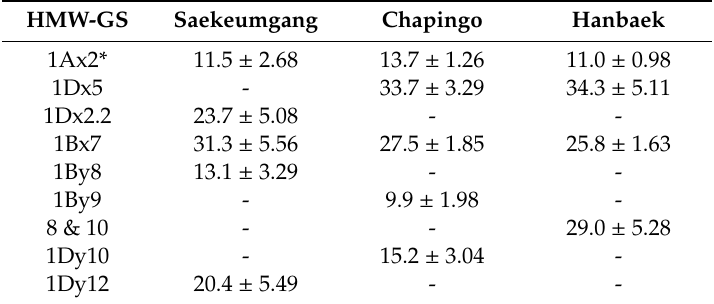
Figure 2. Identification of the 8 & 10 subunits on Lab-on-a-chip. ( a ) Gel-like image of HMW-GS. ( b ) Comparison of the protein quantities between 1By8 and 8 & 10 by electropherogram. ( c ) Comparison of the protein quantities between 1Dy10 and 8 & 10 by electropherogram. Six micrograms of diluted extracted glutenin proteins with denaturing solution were separated by the 2100 Bioanalyzer. The electropherograms were overlaid with the 2100 Expert program. The small numbers on the image refer to each HMW-GS, such as 2.2 is 1Dx2.2 and 12 is 1Dy12. Table 2. The relative protein quantity of HMW-GS for 8 & 10 identification by Lab-on-a-chip. The relative protein quantity of each HMW-GS was analyzed by the band peak area on an electropherogram. Three independent experiments were performed. Data are mean values (%) ± SD.